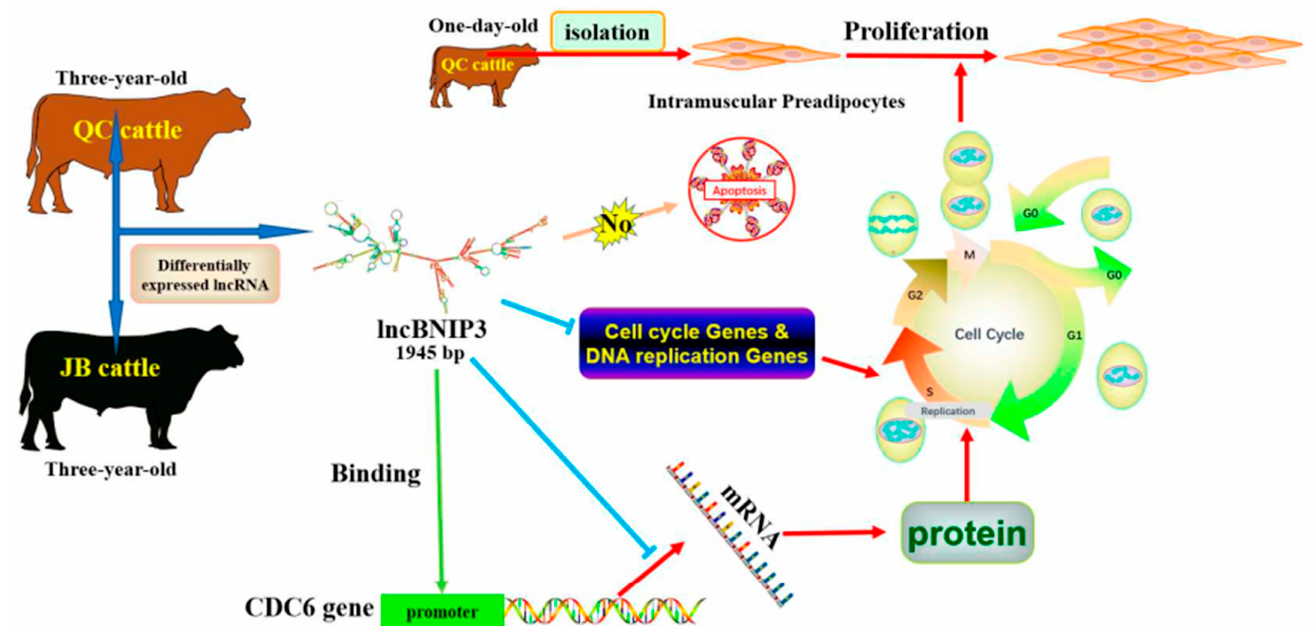
Figure 8. Model of the lncBNIP3 action in inhibiting the proliferation of bovine intramuscular preadipocytes. The green arrow indicate binding, the blue arrows indicate inhibition, and the red arrows indicate promotion.